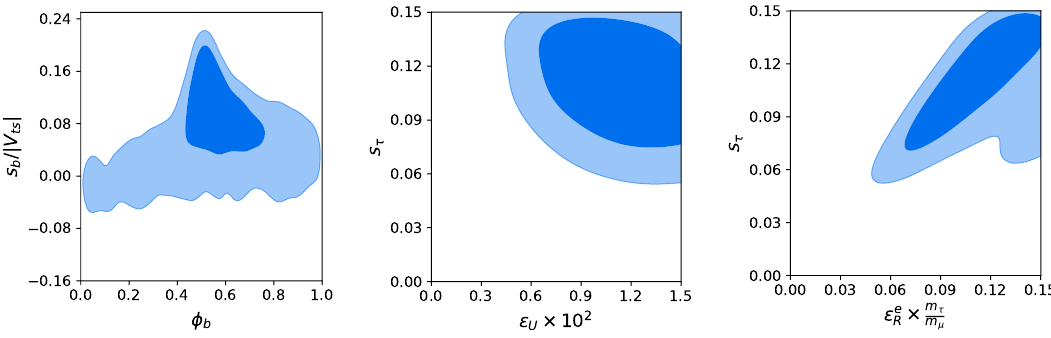
Figure 5 . 68% (dark blue) and 95% (light blue) posterior probabilities of (cid:30) b and s b (left), (cid:15) U and s (cid:28) (mid), and of (cid:15) e and s (cid:28) R